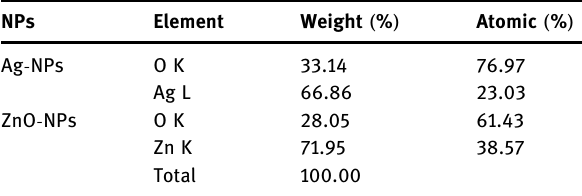
Table 2: EDX analysis ( atomic percentages of elements